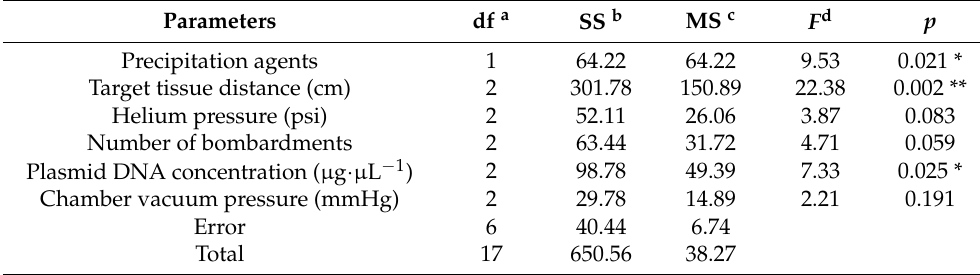
Table 5. Variance analysis of different